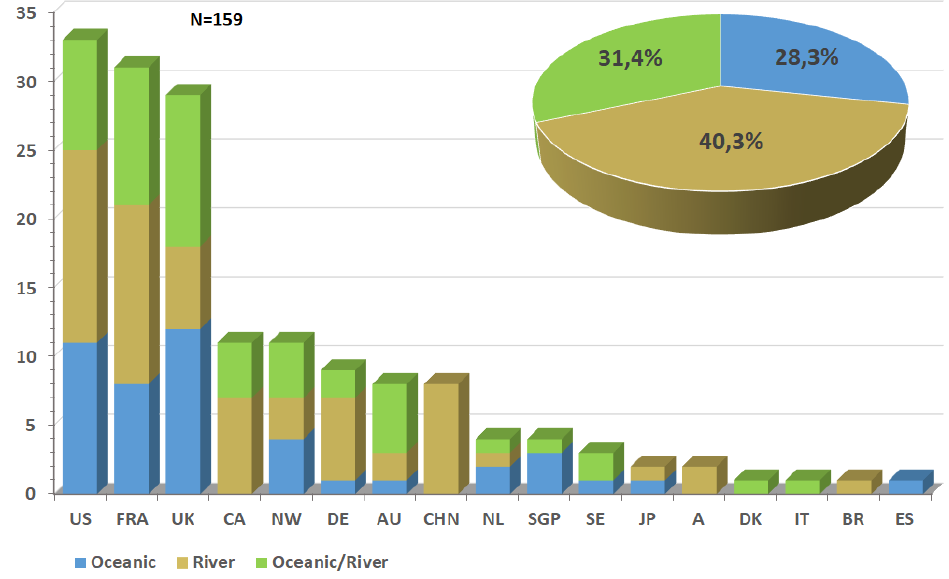
Figure 10. Hydrokinetic market sector [19]. c (cid:13) Reproduced with permission from SEENEOH,